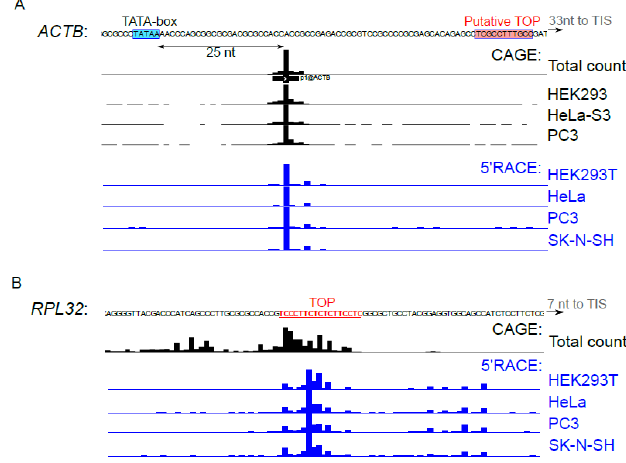
Figure 4. TSS activity in the studied cell types. ( A – B ) HEK293T, HeLa, PC3 or SK-N-SH cells were transfected with pNL2.2-ACTB ( A ) or pNL2.2-RPL32 ( B ). After 24 h, the total RNA was extracted and